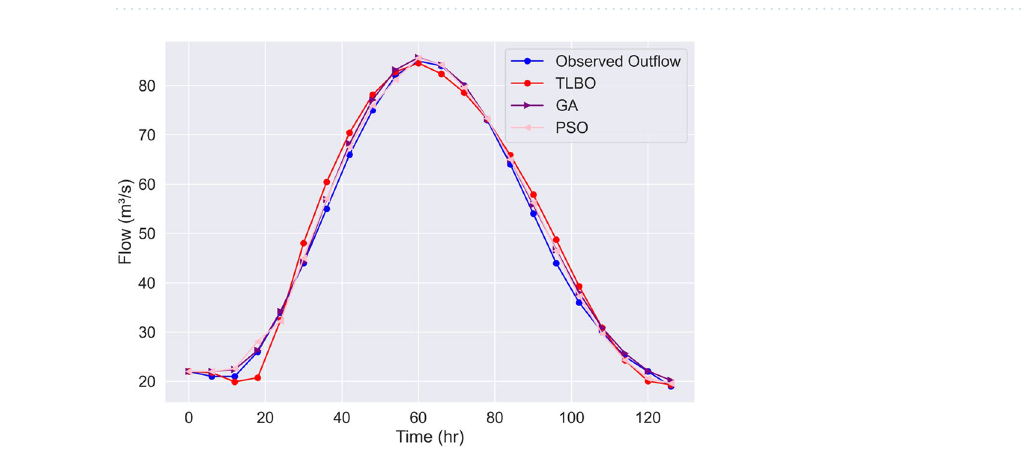
Figure 6. Comparison of TLBO, GA 18 , and PSO 22 performance accuracy simulating the observed outflow timeseries in the Wilson